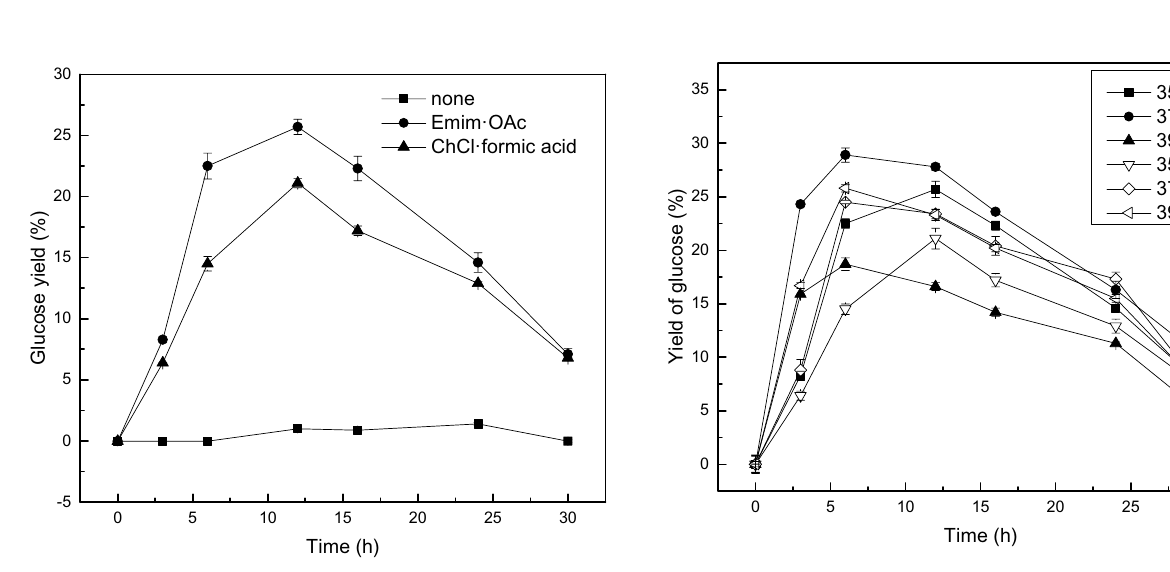
Fig. 11 SEM analysis of corn stover before and after pretreatment